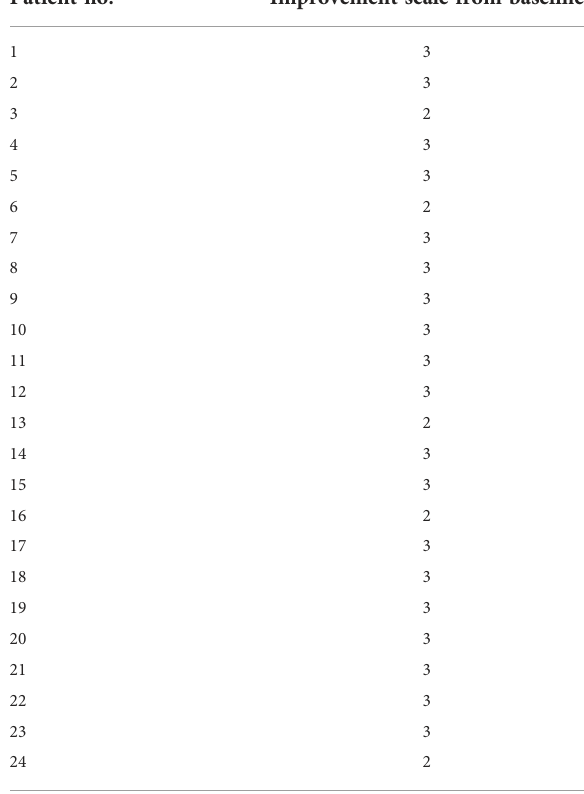
TABLE 5 Local pressure symptoms improvement scale. Patient no.